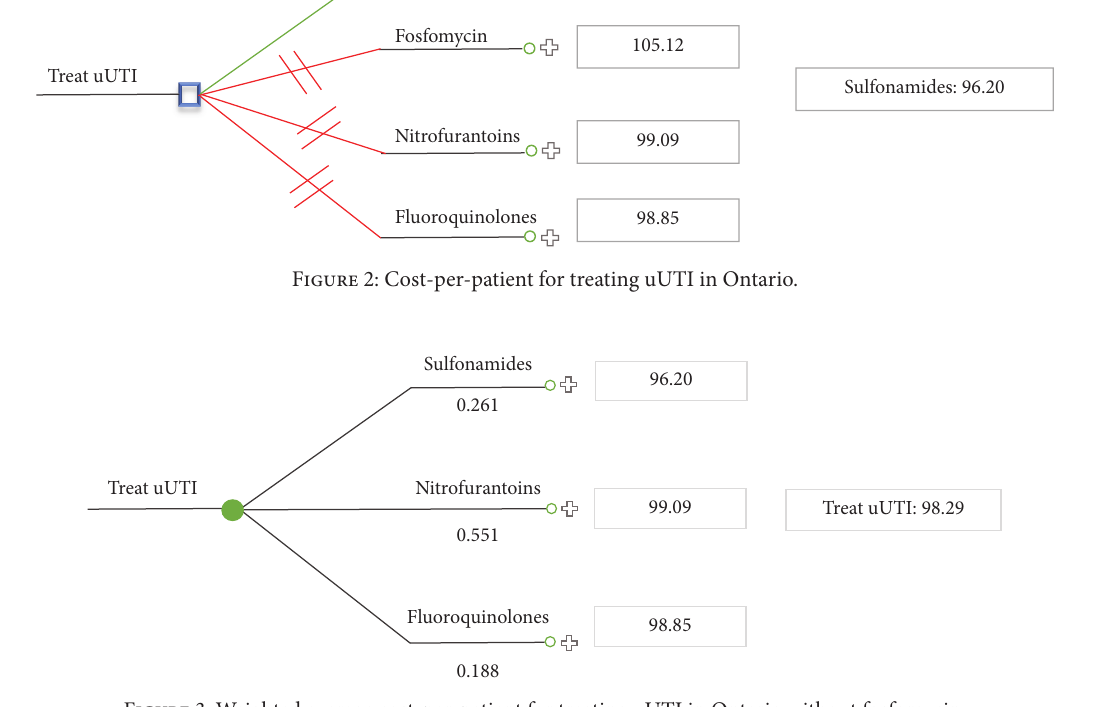
Figure 3: Weighted average cost-per-patient for treating uUTI in Ontario without fosfomycin.